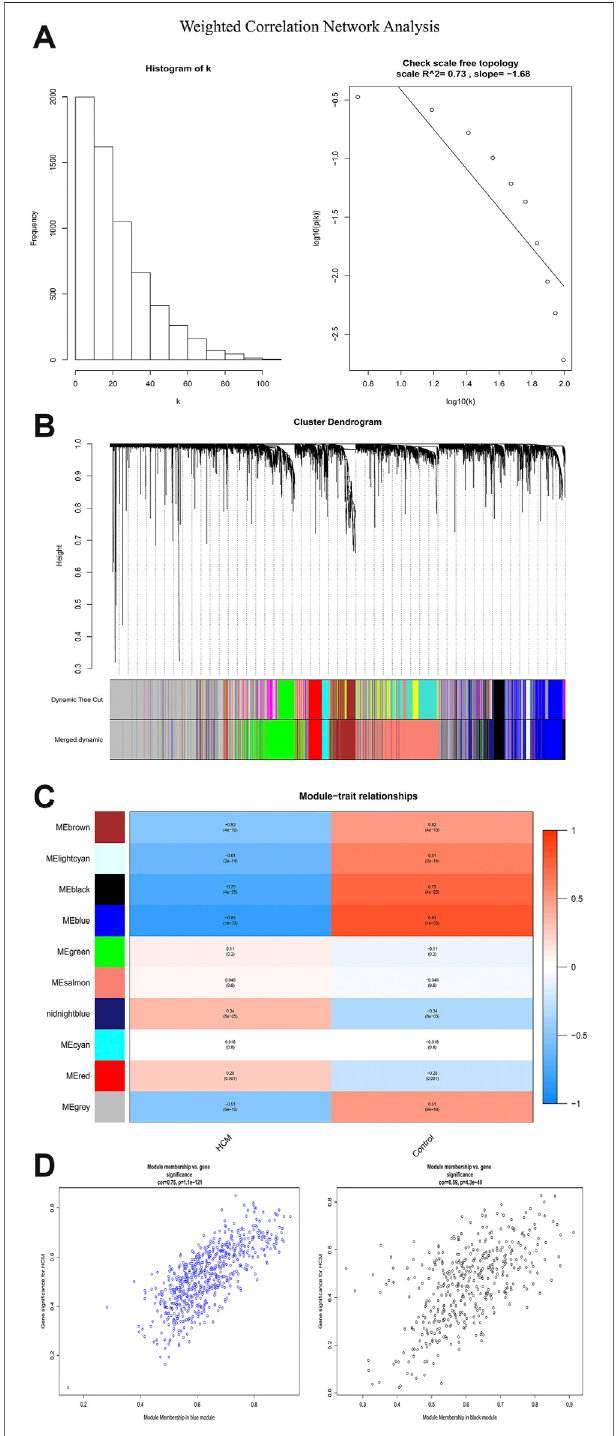
FIGURE 3 | Weighted correlation network analysis. (A) Histogram and check scale free topology. (B) Cluster dendrogram of modules. (C) Heat map of module-HCM relationships. (D) Module memberships in blue and black module and their correlation with HCM. HCM, hypertrophic